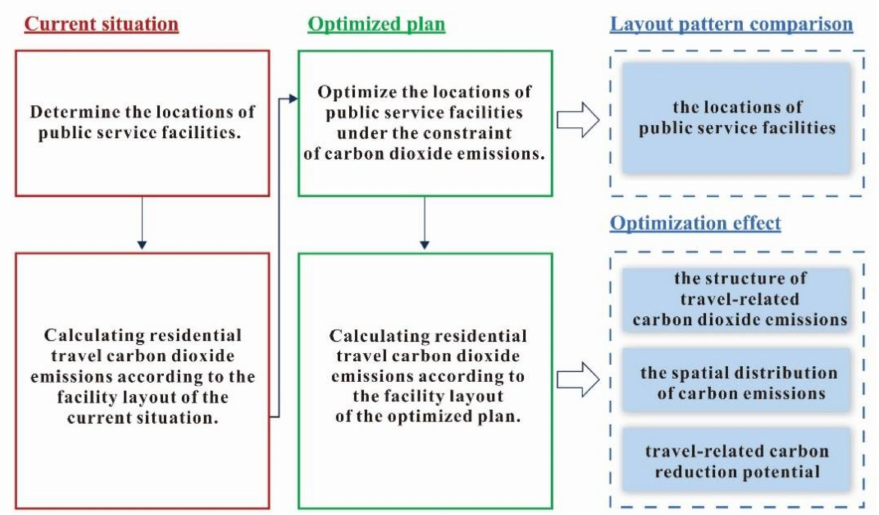
Figure 2. Process of the TS-LC-LPSF and